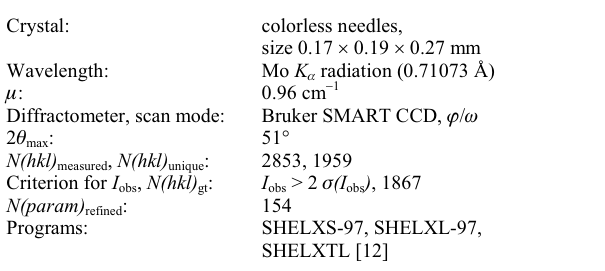
Table 1. Data collection and handling.